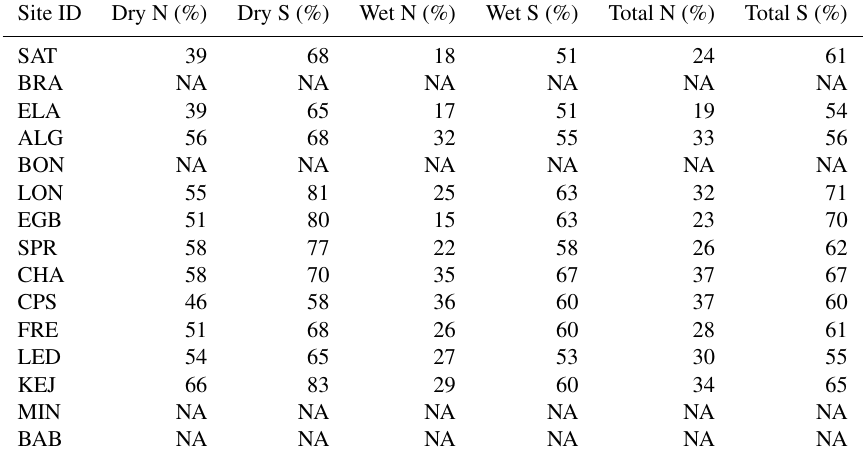
Table 2. Percentage reduction in dry, wet, and total (dry + wet) N and S deposition from 2000–2004 to 2014–2018 period. NA: not